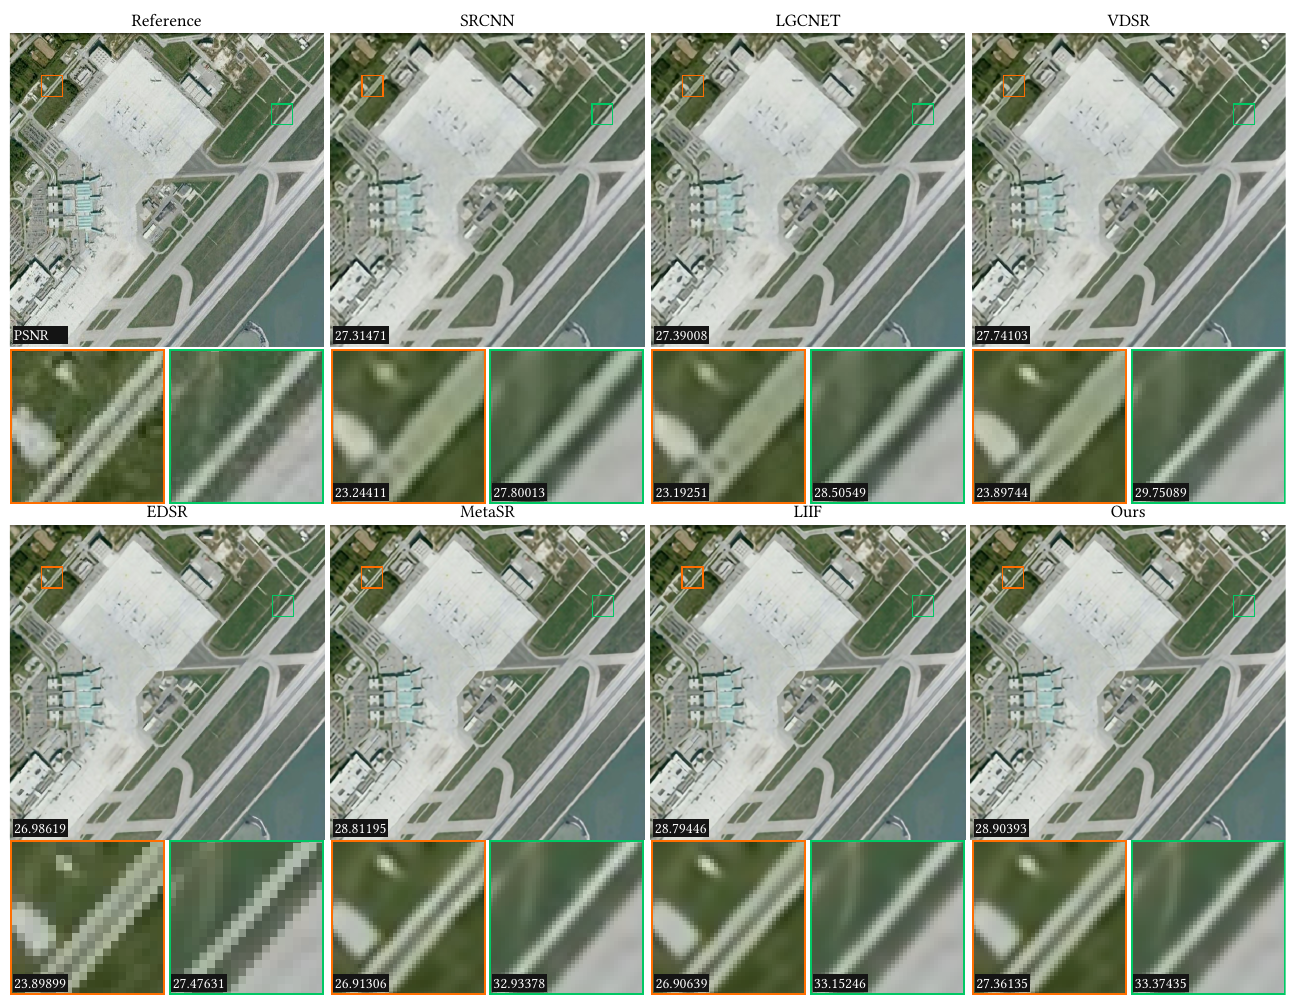
Figure 5. Comparison results of × 4 scale on the Airport_240 scene of the AID dataset. Two local regions are zoomed in to show the detailed results. The PSNR values are listed in the bottom-left